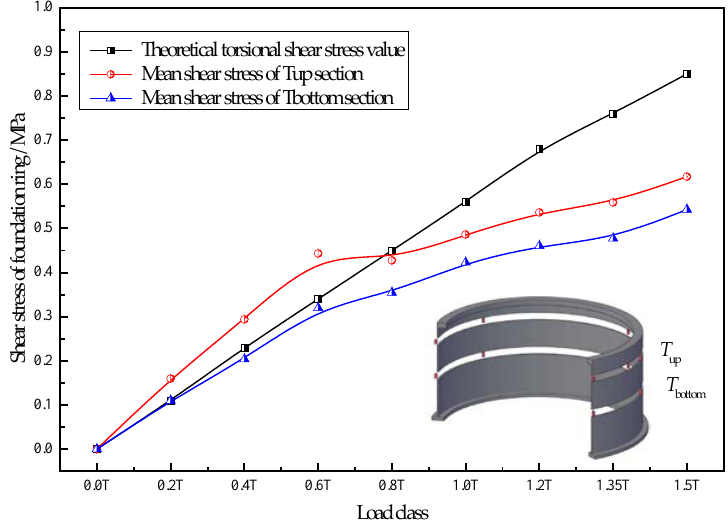
Figure 14. Torsional shear stress in the foundation ring of ZT-4.